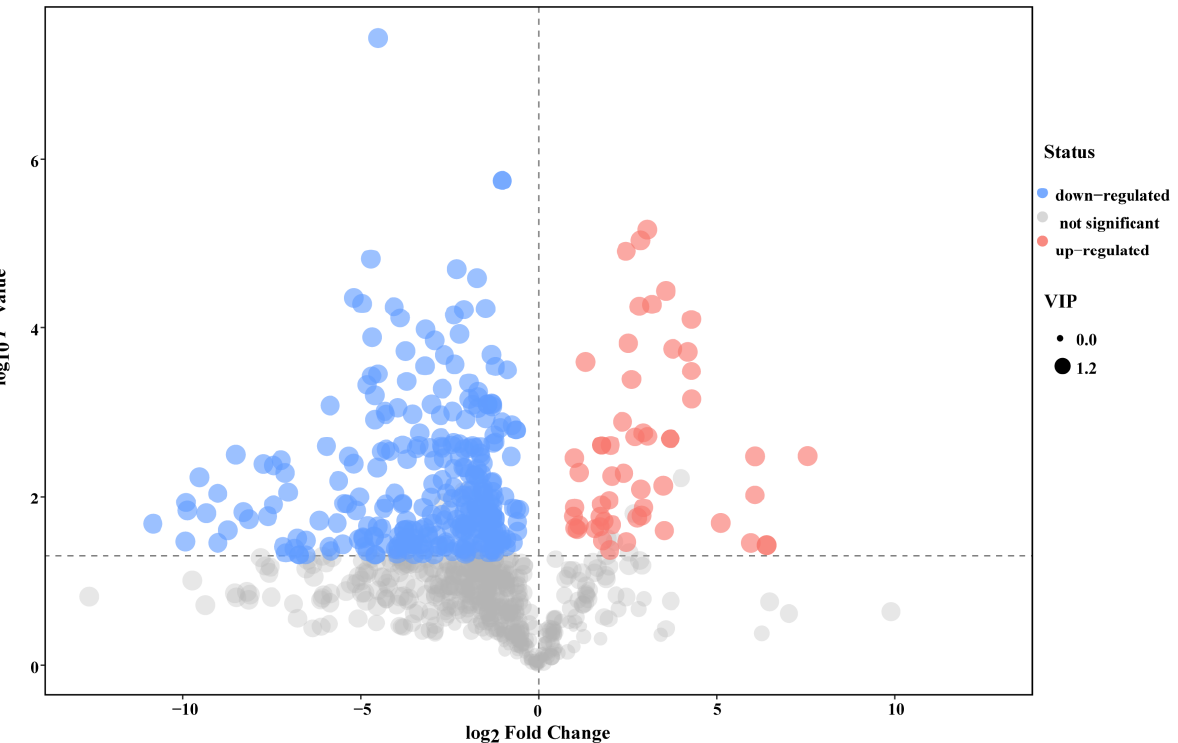
Figure 4. Volcano plot of differential metabolites in the stigmas and petals. Up- and down-regulated metabolites are indicated in red and blue, respectively. Gray represents metabolites that have no significant change.